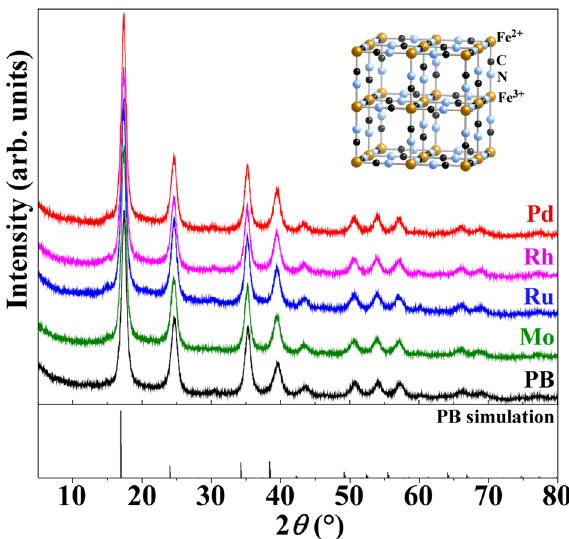
Figure 2. Powder XRD patterns of the pristine and PGMs/Mo-sorbed PBNPs, along with the simulation results (stick bar) of FCC structure (space group: F 43 m ) for PB. The black, green, blue, pink, and red lines represent the pristine, Mo-, Ru-, Rh-, and Pd-sorbed PBNPs, respectively. The crystal structure of PB is shown in the inset.